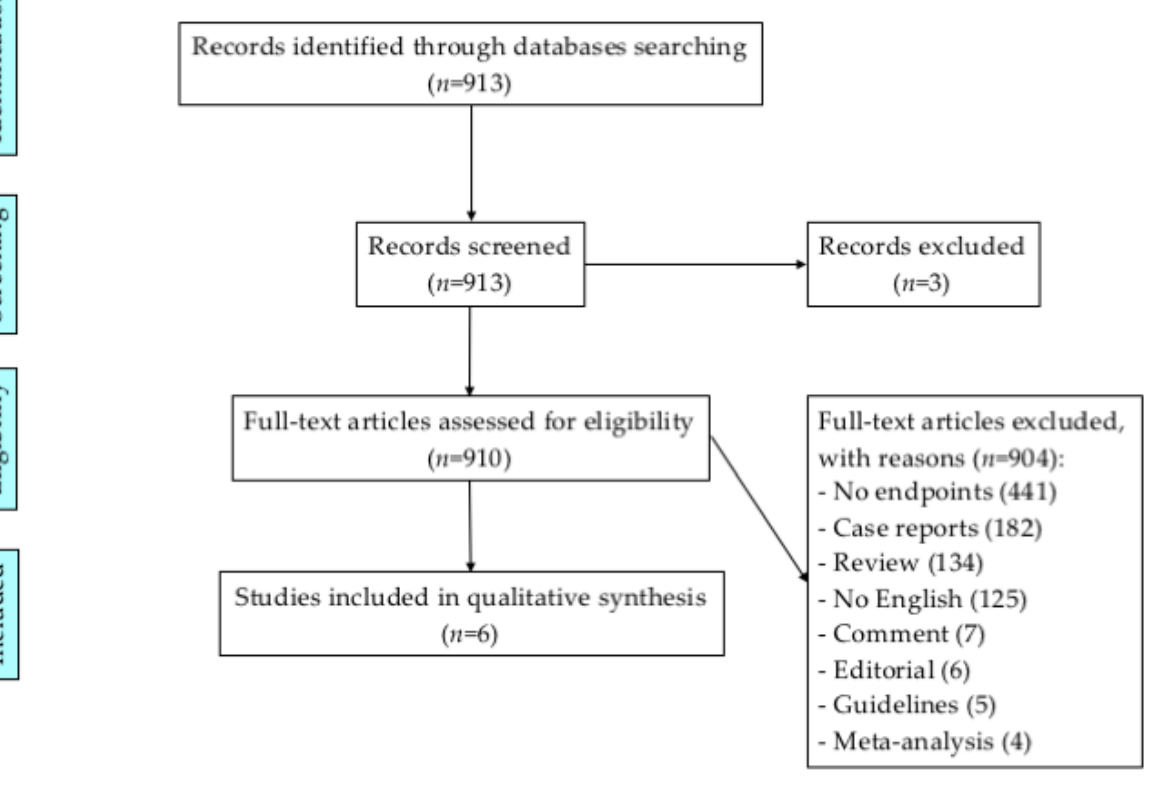
Figure 1. The PRISMA flow diagram.